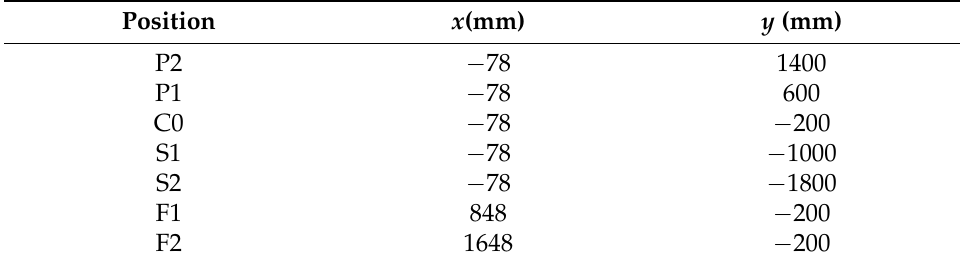
Table 3. Positions of the pressure sensors; (0,0) = center of the